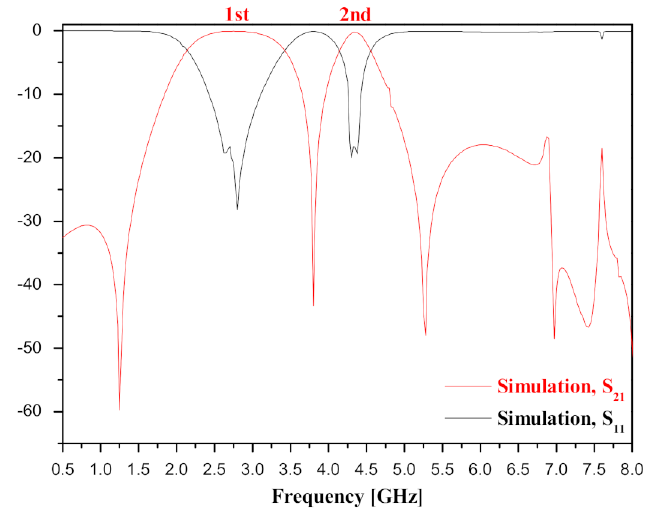
Figure 3. Frequency band response for 2 stage ( a and b parts)